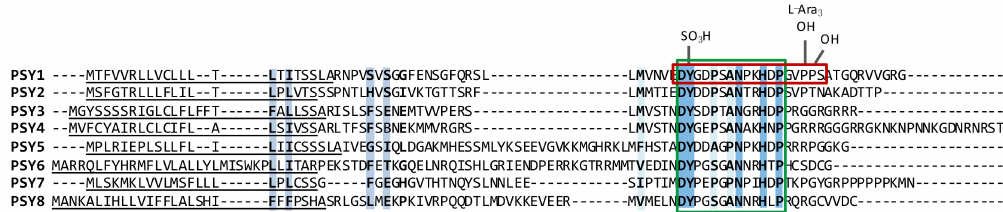
Figure 2. Alignment of the PSY1 precursor peptide and its seven homologs in Arabidopsis . Letters in bold and shades of blue indicate conservation between amino acids with weakly similar properties, amino acids with strongly similar properties, and complete conservation, respectively. Green box highlights the conserved PSY domain and red box emphasizes the mature, active PSY1 peptide with indicated modifications. Predicted secretion signal peptide is underlined. PSY5 is found in four splice variants, of which the shortest is presented in the